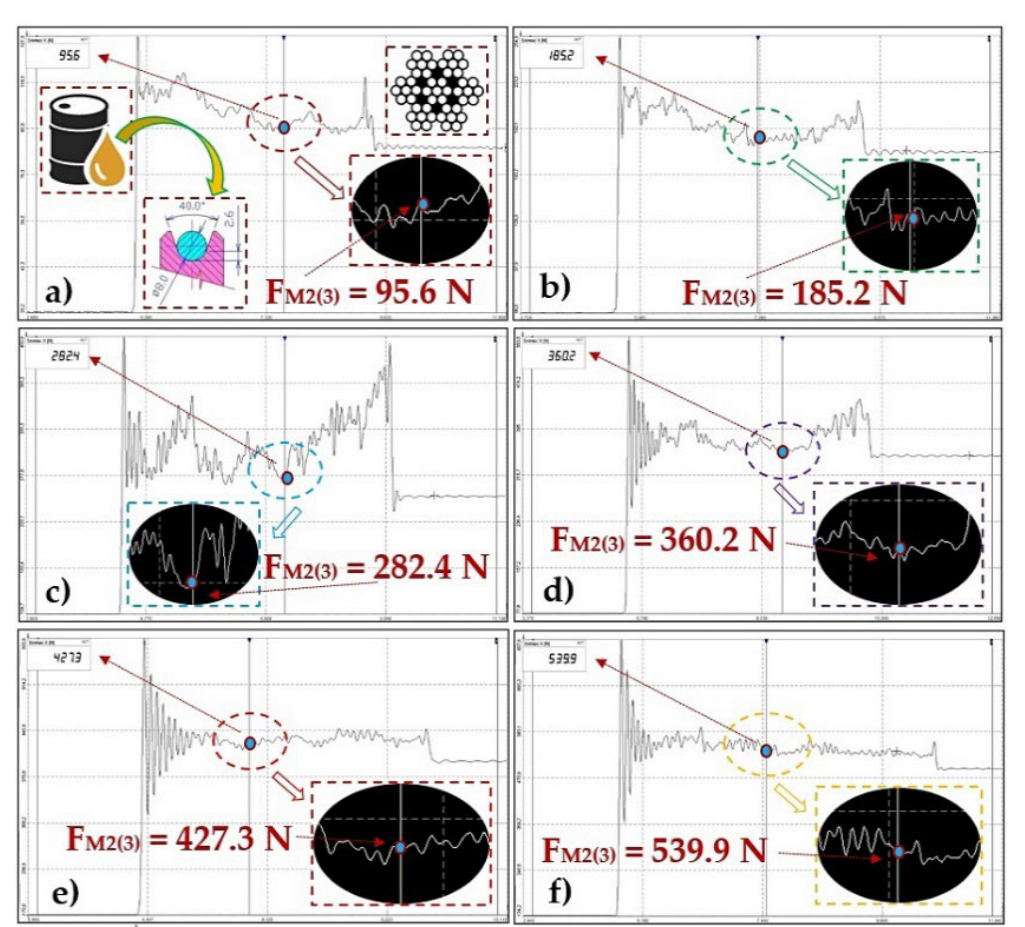
Figure 7d, 6e see Figure 7e, 6f see Figure 7f.